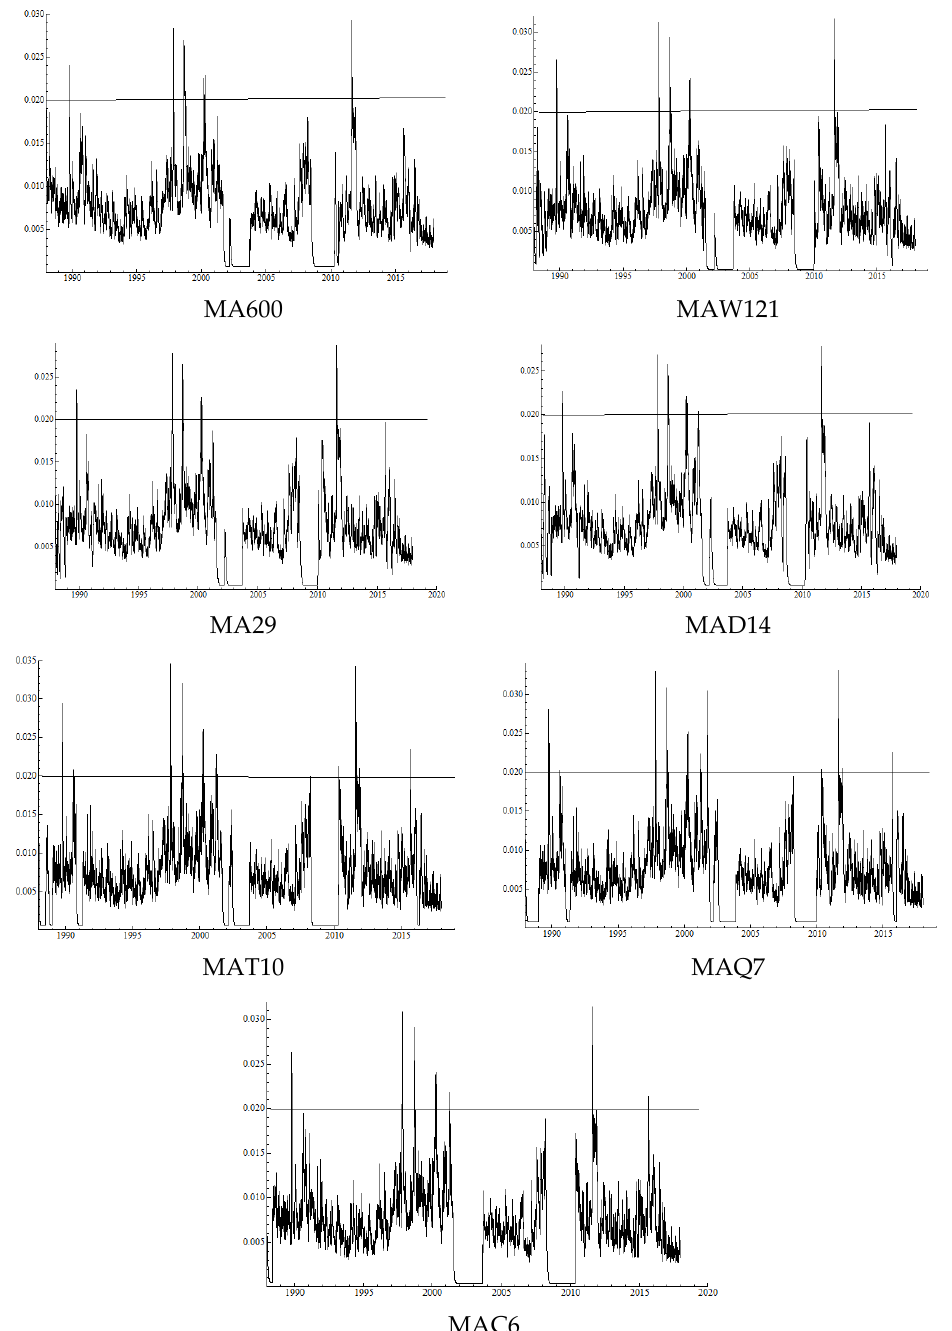
Figure 3. Realized volatilities in 600 trading days rolling window are used. The straight line is the 2% realized volatility bound.